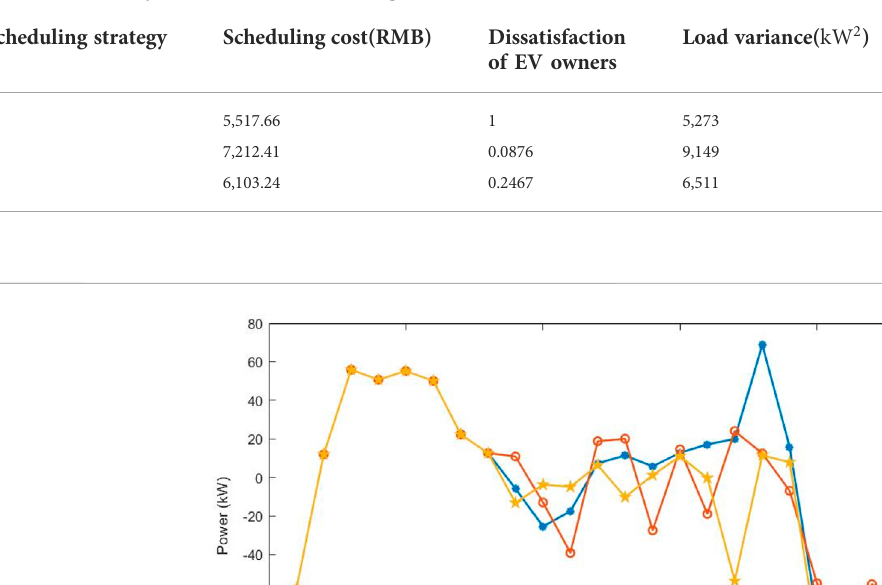
TABLE 3 Index comparison under different strategies.